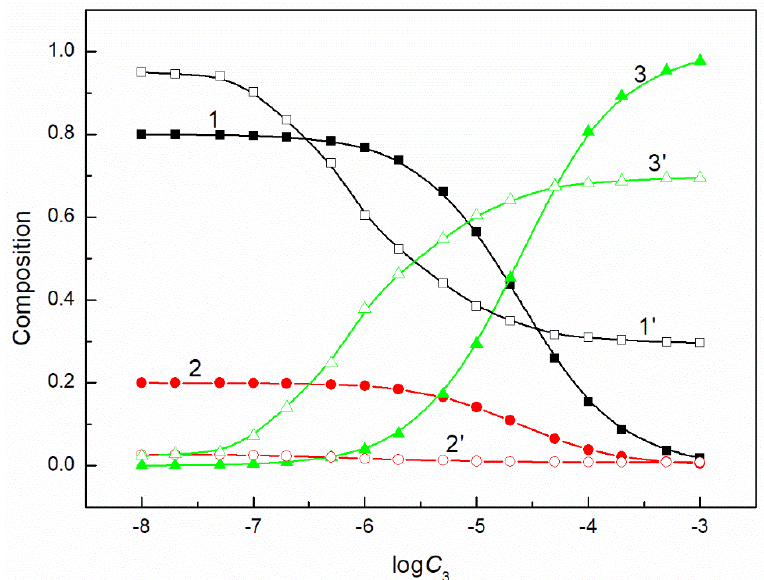
Figure 6. A plot of the composition of the ternary mixture including CTAB, TX100 and FC1 in the monolayer (curves 1–3) and in the bulk phase (curves 1’–3’) at the constant C 12 and γ LV = 50 mN/m vs. the logarithm of the FC1 concentration ( logC 3 ). Curves 1, 1’ correspond to CTAB, curves 2, 2’ correspond to TX100 and curves 3–3’ to FC1.